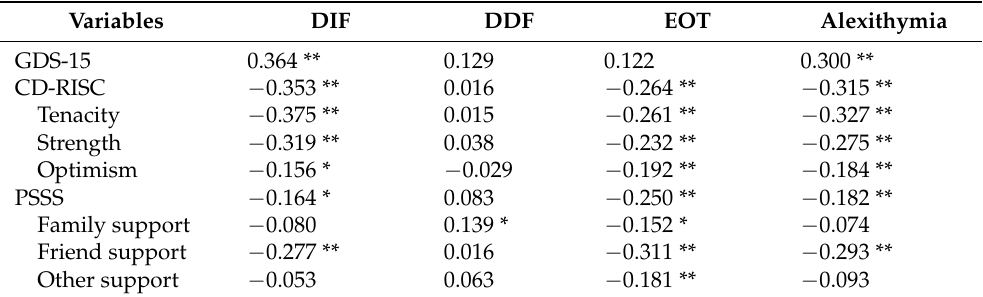
Table 2. Correlation analysis of alexithymia, depression, psychological resilience, and social